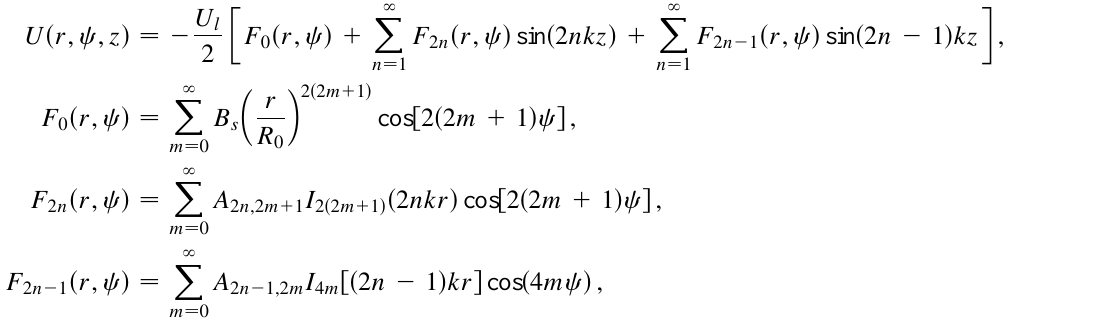
p l´ n r max is about 2.3 mm. As a conse-